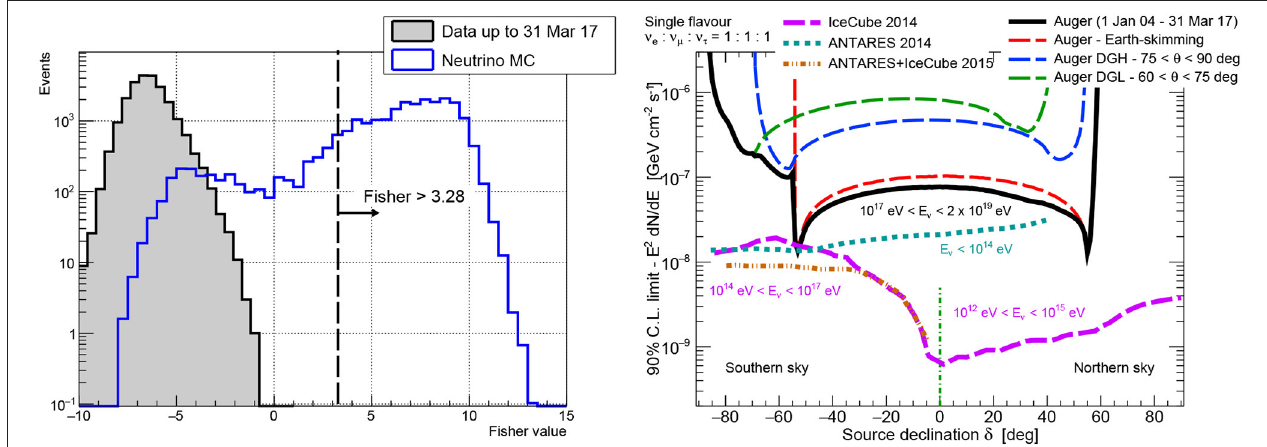
FIGURE 1 | (Left) Distribution of the Fisher variable for the DGH search (see text) for simulations compared to a small fraction of the data and assumed to be due to cosmic rays. The cut is made at a value of the Fisher variable of 3.28. (Right) Limits to the point source fluxes as a function of equatorial declination obtained from the non-observation of ES and DGH neutrino candidates up to March 31st 2017 (from Zas,